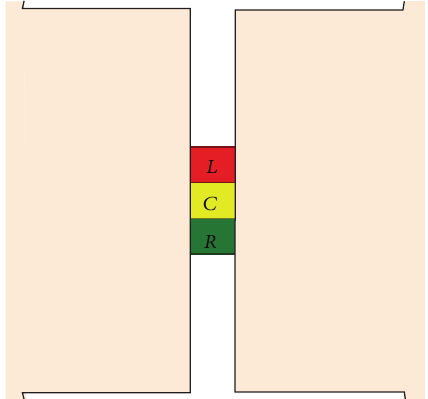
Figure 3: RF MEMS switches in the layout of the